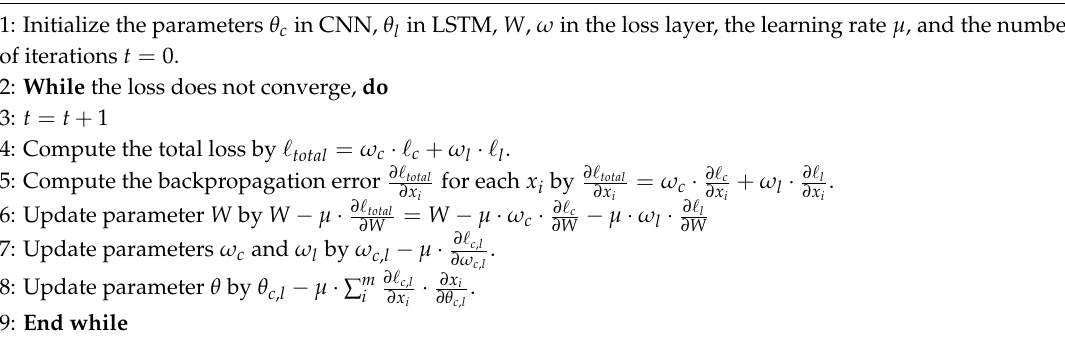
Algorithm 1. Training HDMF (parallel)